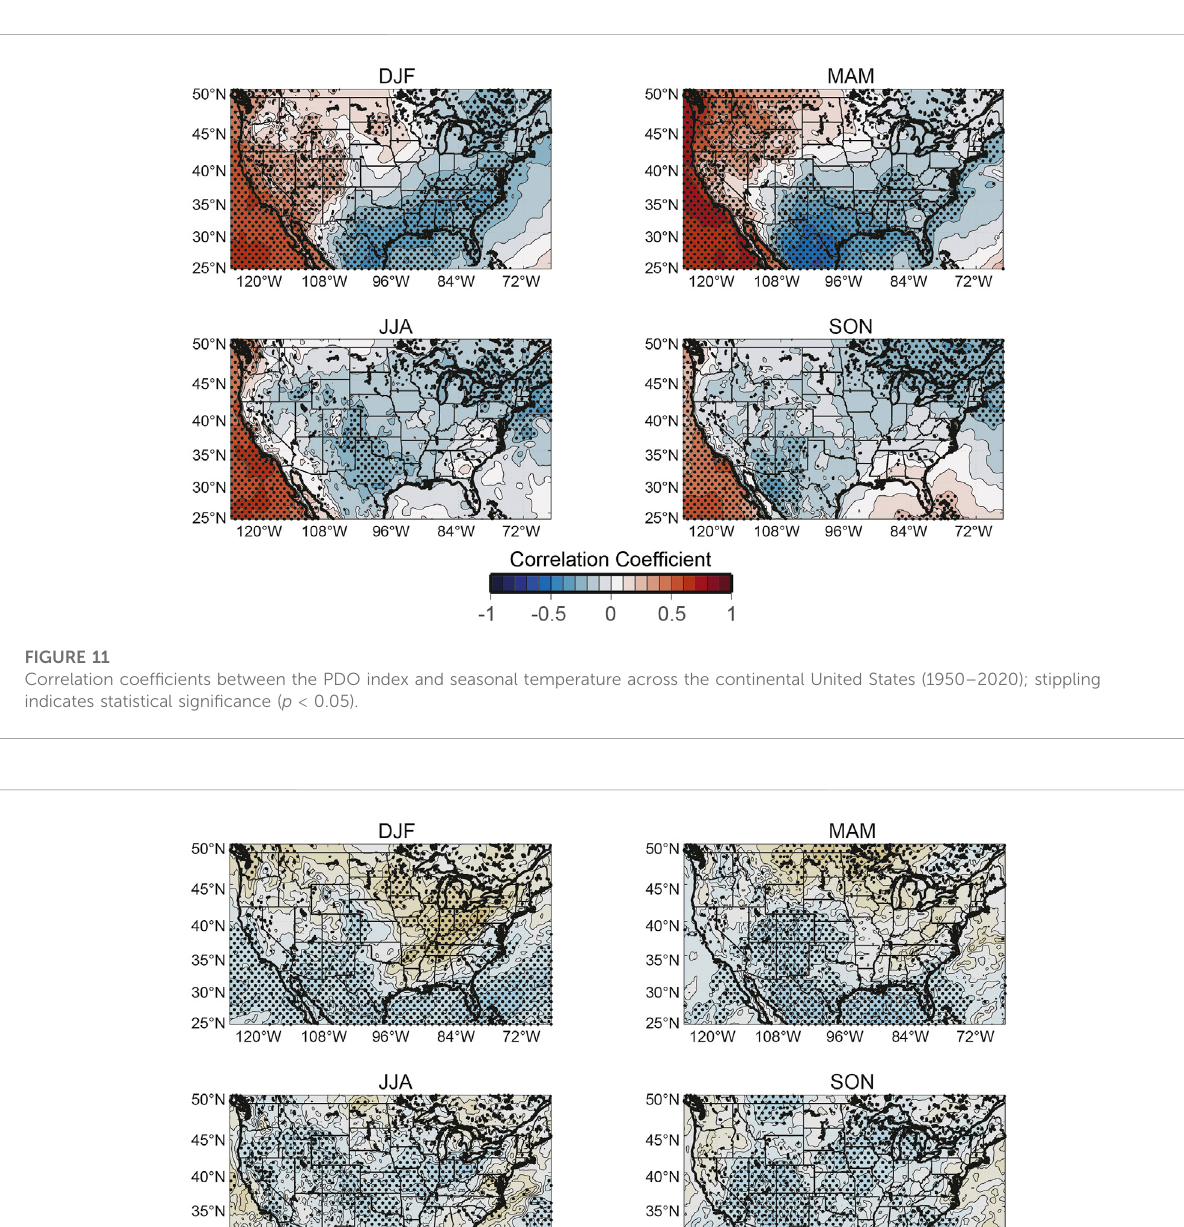
Tootle et al. (2005) linked the PDO ’ s warm phase with signi fi cantly enhanced stream fl ow along the eastern Texas and Louisiana coast, and in eastern Oklahoma, with Sagarika et al. (2015) and Rodgers et al. (2020) concurring with these fi ndings in the SCUSA but with low explained variance (Mantua et al., 1997).